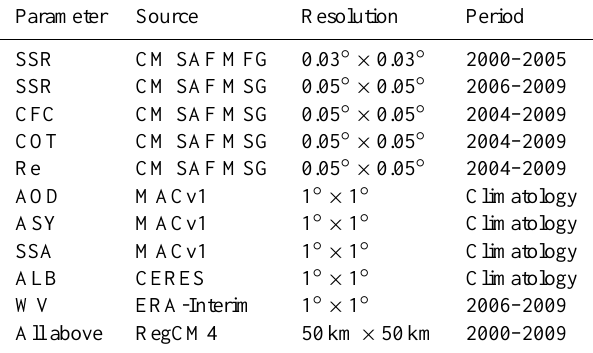
Table 1. List of the parameters being analyzed in this work, their sources, the original resolution at which the data were acquired and the corresponding time